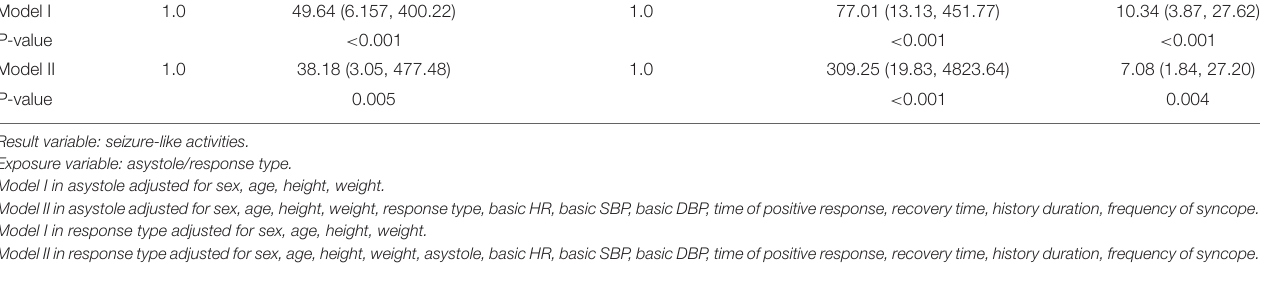
TABLE 3 | The relationship between asystole, response type and seizure-like activities in different models [OR (95%CI)]. Asystole Response